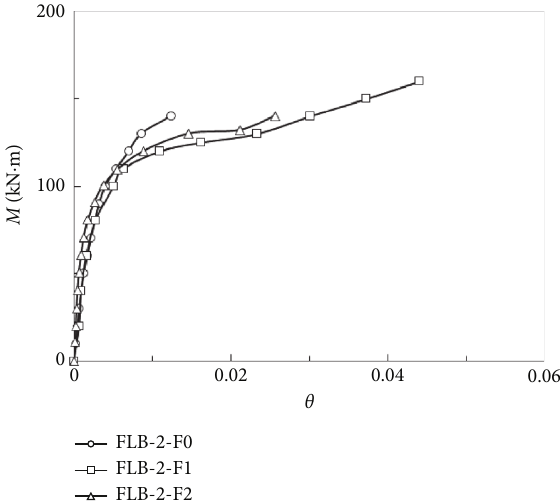
Figure 11: Moment-rotation angle curves for specimens under pure